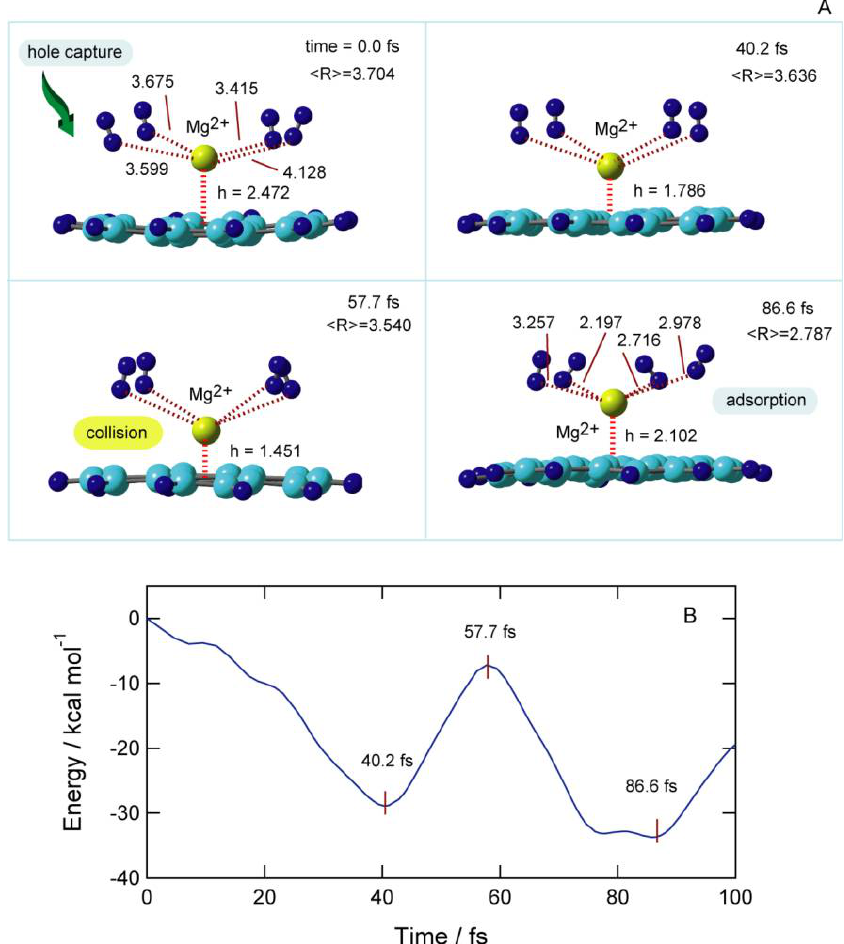
Figure 13. ( A ) The snapshots of the GNF–Mg 2+ –(H 2 ) 4 following the hole capture of GNF–Mg + –(H 2 ) 4 . ( B ) The time evolution of the potential energy of GNF–Mg 2+ –(H 2 ) 4 . Direct AIMD calculations were carried out at the CAM-B3LYP/6-31G(d) level. The initial geometry was taken from one of the structures in the simulation of GNF–Mg + -(H 2 ) 4 (indicated by “selected point” in Figure 12). The distances and heights are in Å. Reprinted with permission from [45]. Copyright 2021 American Chemical Society.